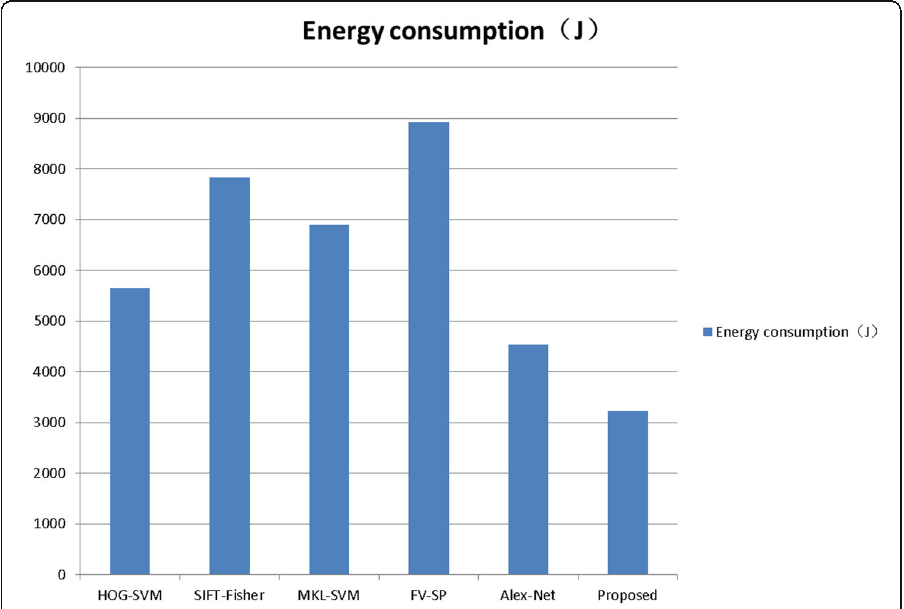
Fig. 7 The comparison of energy consumption